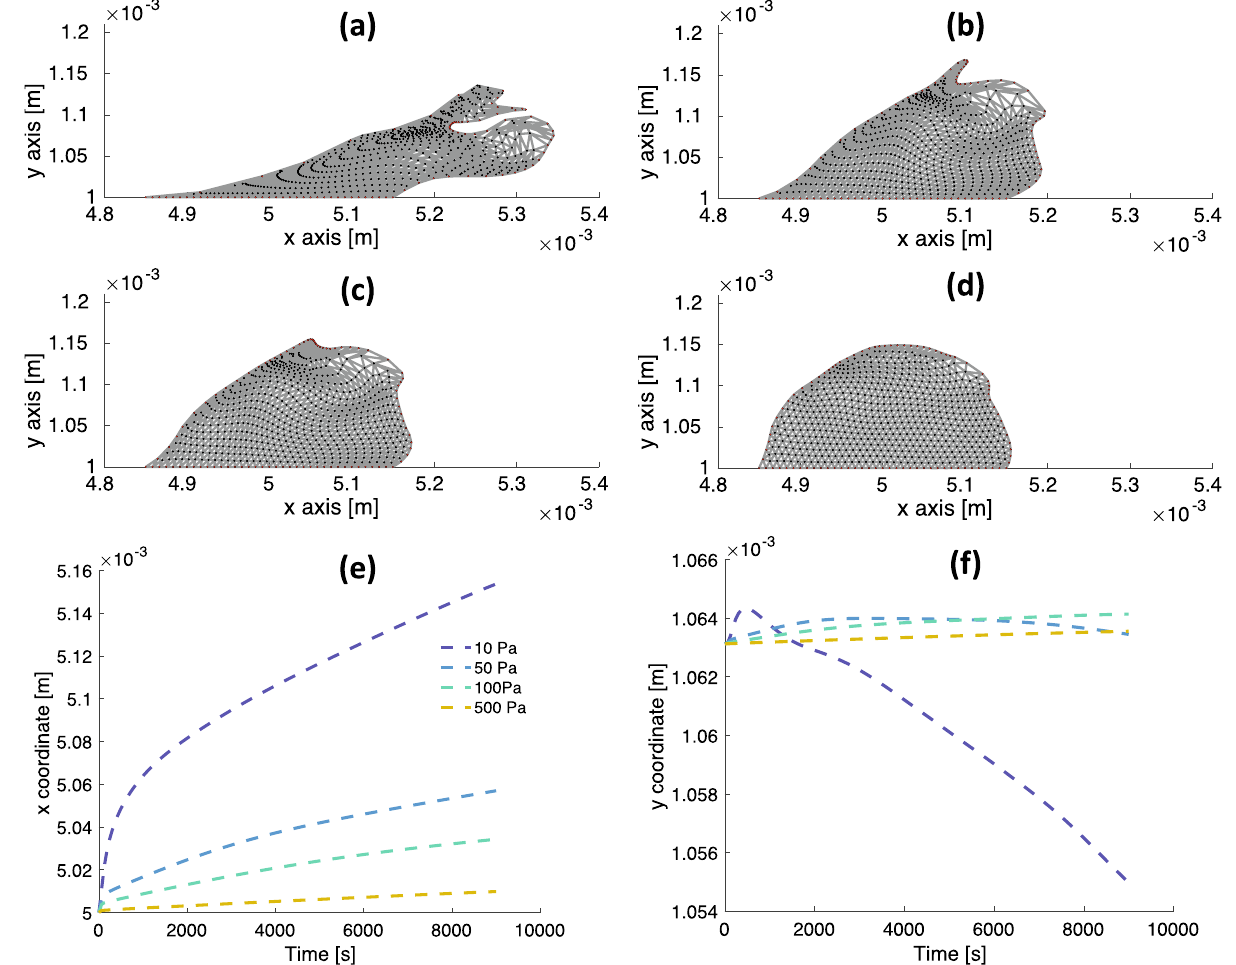
Figure 5. Comparison of deformation in shear flow between viscoelastic biofilms with relaxations time of 18 min at a flow rate of u max = 5 × 10 − 6 m/s. ( a )-( d ) From left to right, top to bottom: E = 10, 50, 100, 500 Pa. In shear flow, soft biofilms deform more and develop larger protrusions than stiff biofilms. ( e ) The x -coordinate of center of mass versus time. All the biofilms have a relaxation time near 18 min, which requires the viscosity increase in proportion to the elastic modulus. Thus, the asymptotic slope approaches zero in the limit of large elastic modulus. ( f ) The y -coordinate of center of mass versus time. Relative to the change in the x -coordinate, the change of the y -coordinate is an order of magnitude smaller, indicating the flow acts primarily to shear the